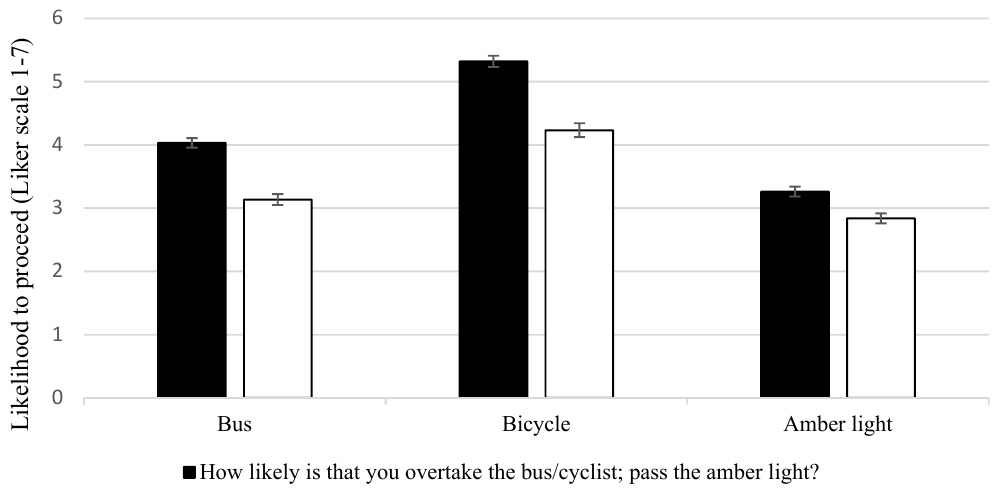
Figure 3. Ratings for the different type of risky scenarios across the two questions: “How likely is that you overtake the bus/cyclist; pass the amber light?” and “How likely is that you accelerate at this point?” (with standard error bars).